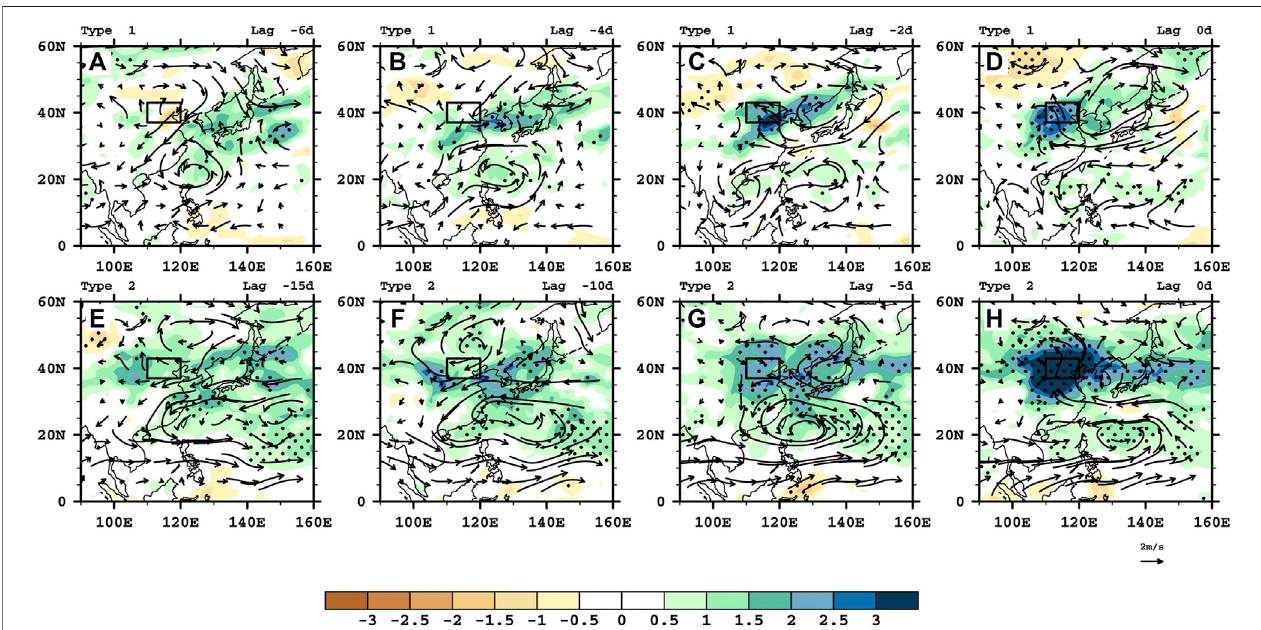
FIGURE 8 | Composited speci fi c humidity anomalies (shading, unit: g · kg − 1 ) and wind anomalies (vector, unit: m · s − 1 ) at 850 hPa during day 6 (A) , 4 (B) , 2 (C) , and 0 (D) prior to the onset of type 1 PEPEs. Composited speci fi c humidity anomalies (shading, unit: g · kg − 1 ) and wind anomalies (vector, unit: m · s − 1 ) at 850 hPa during day − 15 (E) , − 10 (F) , − 5 (G) , and 0 (H) prior to the onset of type 2 PEPEs. Dotted areas indicate 95% con fi dence level.